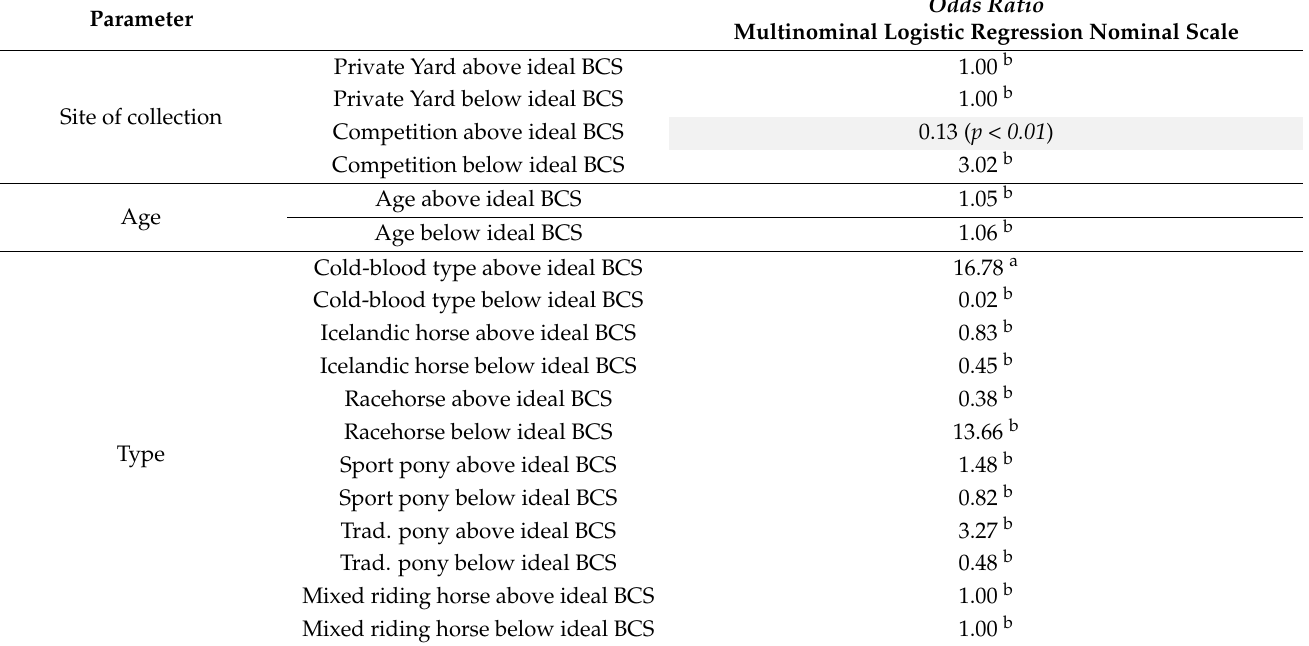
Table 4. Odds ratio for multinominal logistic regression, nominal scale. Data sorted by <5 BCS